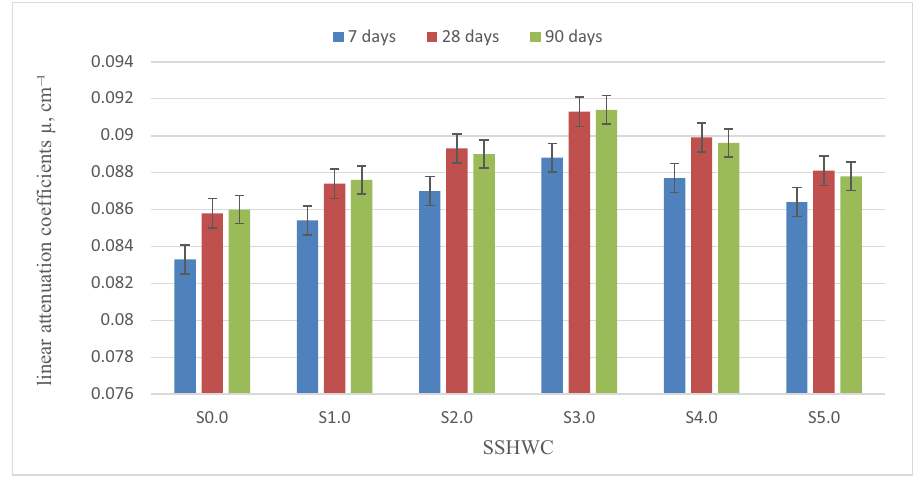
Figure 15: Linear attenuation coe ffi cient ( μ ) at 7, 28, and 90 days for concrete with di ff erent NSS